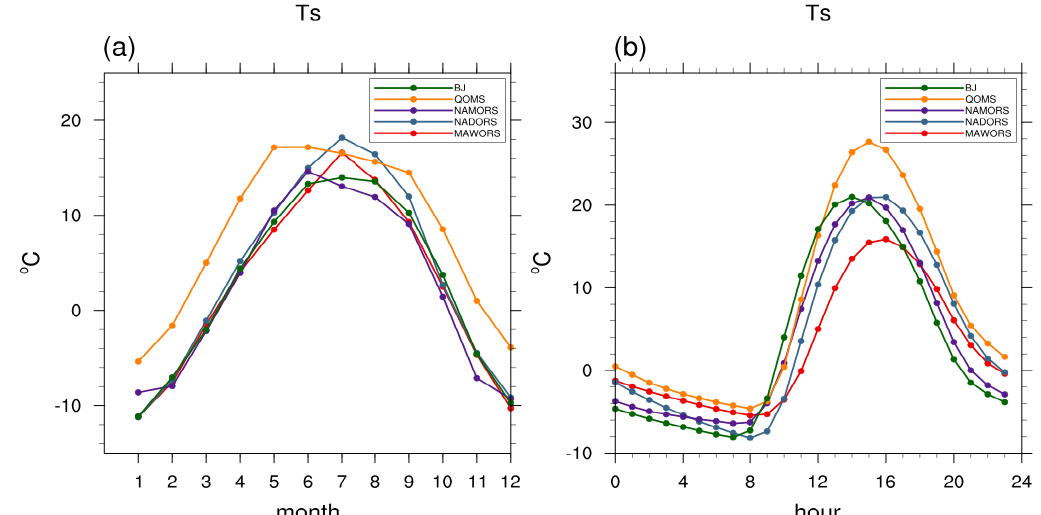
Figure 23. Annual variation of surface temperature ( a ) and diurnal variation of surface temperature ( b ) at each station.